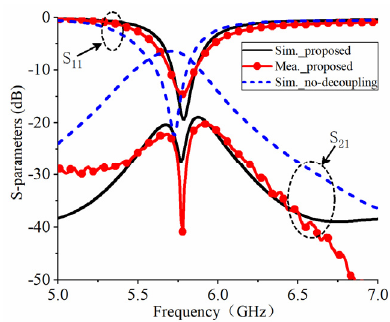
Figure 6. S-parameters comparisons between the simulation, measurement and the no-decoupling.